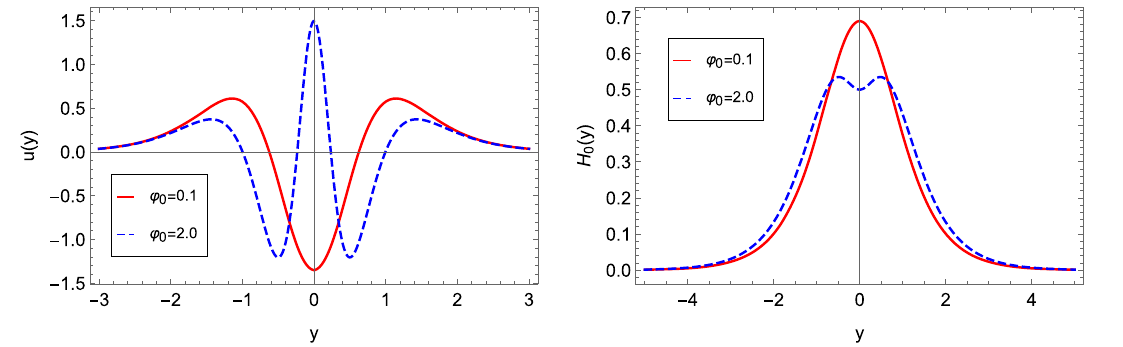
U might be a single or a double well, potentially leading to the gravi- ton mode to be split in two peaks. The finiteness of the integral of H 0 implies that the zero graviton mode is